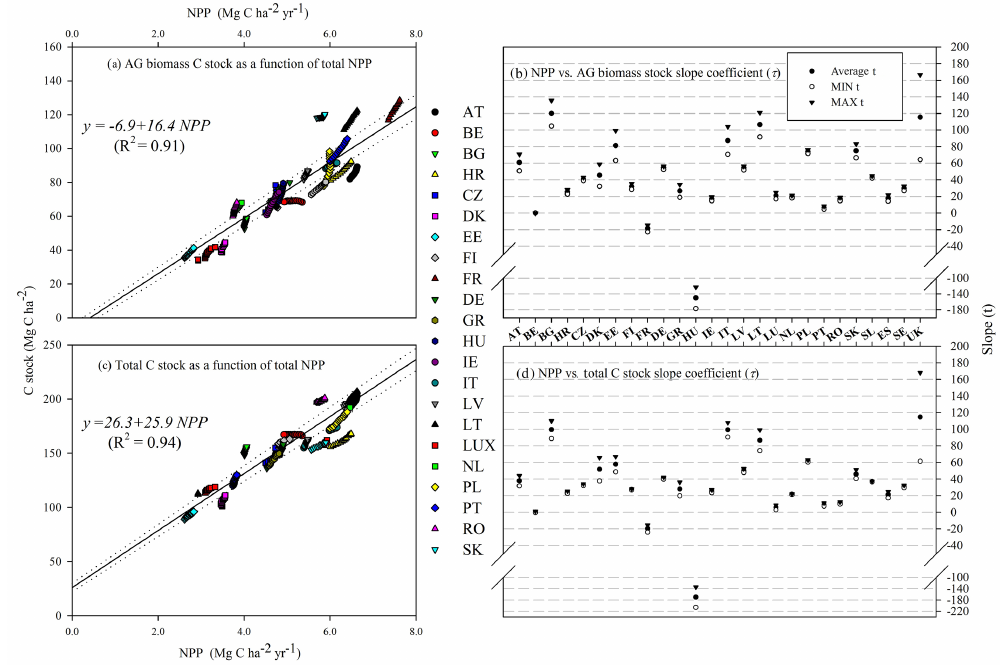
Figure 6. Yearly aboveground living biomass (a ) and total (c) C stock (MgCha − 1 ) as a function of total NPP (MgCha − 1 yr − 1 ) , for the historical period 2000–2012, excluding possible outliers (i.e., years with a distance greater than three interquartile ranges from the medians; SAS Institute Inc., 1990) due to extreme events such as exceptional disturbances. Plots (b) and (d) report, for each country, the slope ( τ ± 95% confidence interval) of the linear regression model ( y = a + τx) applied to the previous values for each country (reported on the x axis). In plots (a) and (c) , we also highlighted the regression model estimated, at EU level, including all the countries, with the corresponding equation and coefficient of regression ( R 2 )